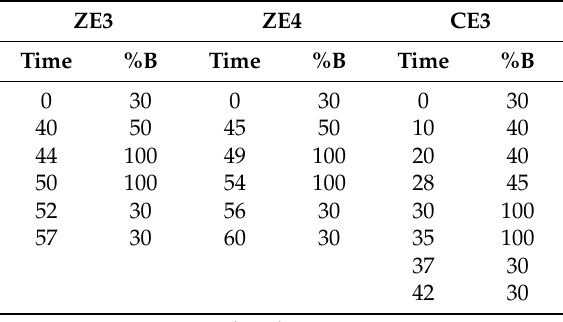
Table 2. Gradient system of isolated compounds from different